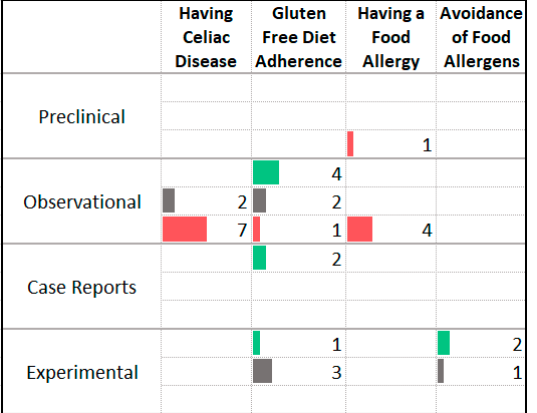
Figure 14. Studies assessing food allergies or sensitivities and anxiety. █ Higher intake or levels associated with decreased anxiety. █ No association between intake or levels and anxiety. █ Higher intake or levels associated with increased anxiety.